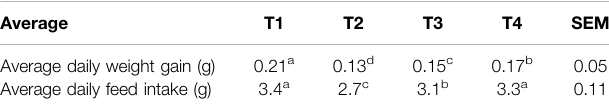
TABLE 4 | The averages of mice body weight changes and feed intake upon receiving different treatments.